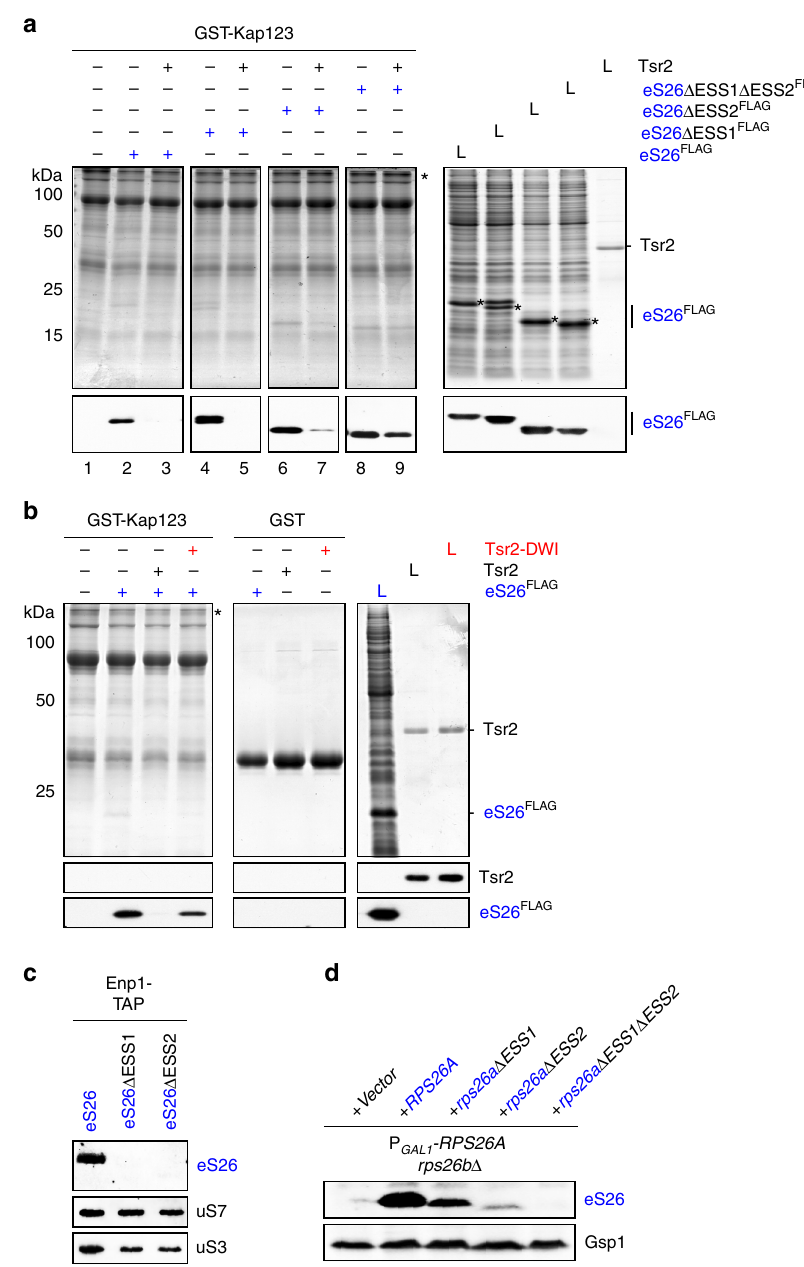
Fig. 4 ESSs mediate Tsr2-dependent importin:eS26 complex disassembly. a Tsr2 cannot ef fi ciently dissociate the Kap123:eS26 Δ ESS1 Δ ESS2 FLAG complex. The complex of GST-Kap123 with eS26 FLAG , eS26 Δ ESS1 FLAG eS26 Δ ESS2 FLAG or eS26 Δ ESS1 Δ ESS2 FLAG was immobilized on Glutathione Sepharose and incubated with either buffer alone or with Tsr2 before pull-down. L = input (1:10 diluted). b Tsr2 DWI mutant does not dissociate a Kap123:eS26 complex. The complex of GST-Kap123 with eS26 FLAG was incubated with either buffer alone, puri fi ed Tsr2 or Tsr2 DWI before pull-down. L = input (1:10 diluted). c Ef fi cient recruitment of eS26 to pre-40S requires both of the ESSs. Enp1-TAP was isolated from P GAL1 - RPS26Arps26b Δ strain transformed with WT eS26 or eS26 lacking ESS1 or ESS2. After tandem af fi nity puri fi cation, eluates were separated by 4 – 12% gradient SDS-PAGE and subjected to western analyses using indicated antibodies. Protein levels of uS7, uS3 served as a loading control. d Protein levels of eS26, eS26 Δ ESS1, eS26 Δ ESS2 and eS26 Δ ESS1 Δ ESS2 in whole-cell extracts of P GAL1 - RPS26Arps26b Δ strain were determined by western analyses using α -eS26 antibodies. Gsp1 protein